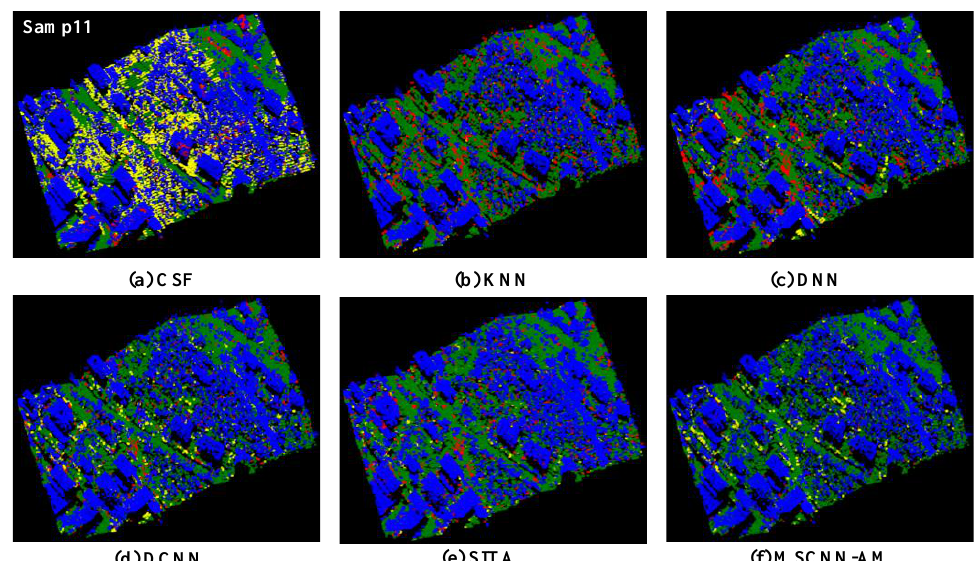
Figure 9. The filtering results of six methods on Samp11. ( a ) CSF; ( b ) KNN; ( c ) DNN; ( d ) DCNN; ( e ) SITA; ( f ) MSCNN-AM. (Green: correctly classified ground points; Blue: correctly classified non-ground points; Yellow: misclassified non-ground points; Red: misclassified ground points).